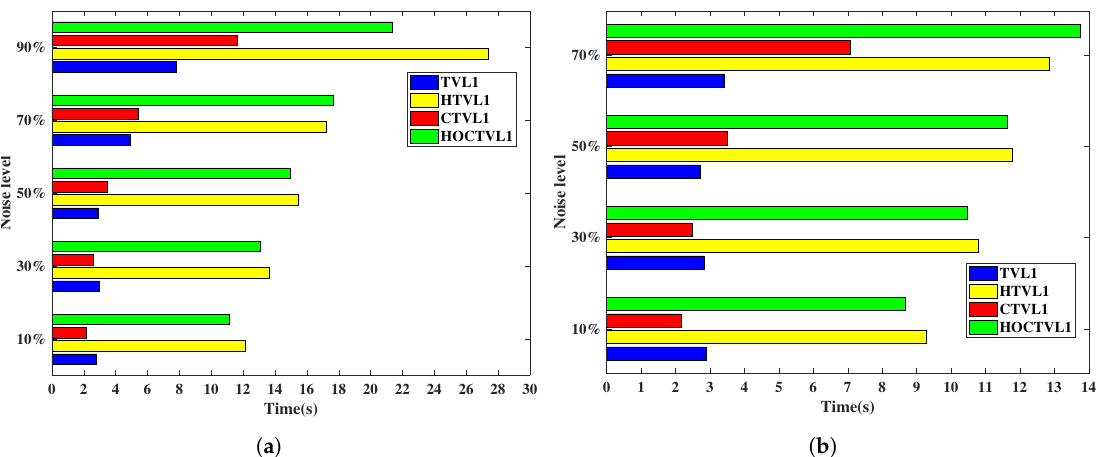
Figure 15. Running time of four different models for Lena corrupted by Gaussian blur and impulse noise. ( a ) Salt-and-pepper noise; ( b ) Random-valued